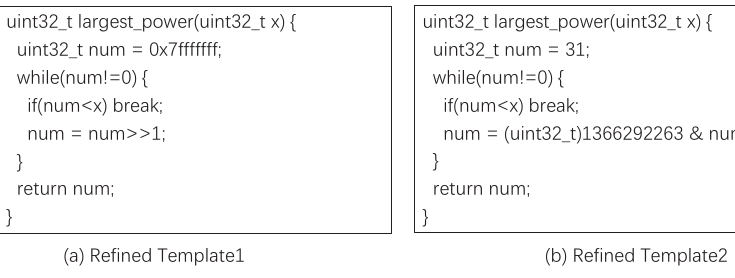
Figure 11. Refined templates of Figure 10b,c. Table 1. Experimental results with Template1 and